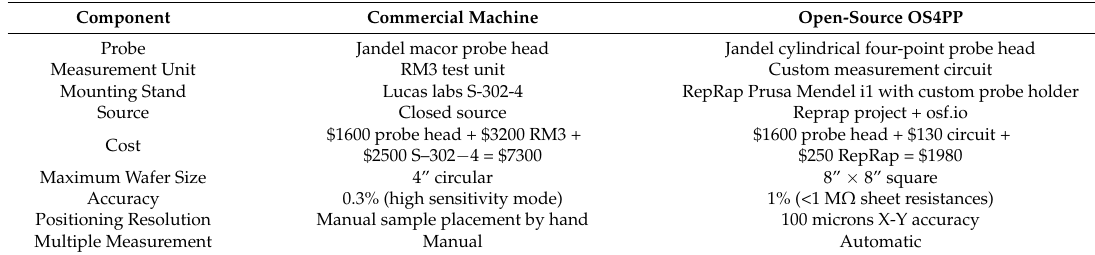
Table 2. Comparison of commercial proprietary machine with